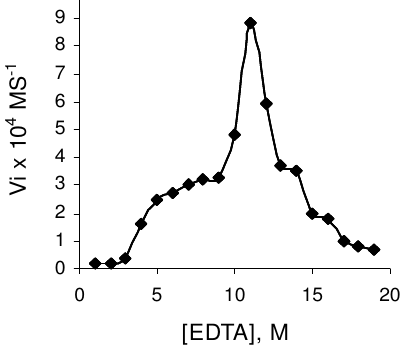
Figure 3. Effect of EDTA on initial rate at [Fe(CN) 64- ] = 3.5 X 10 -2 M, [Hg 2+ ] = 3 x 10 -5 M, pH = 5, Temp =25 0 C and I = 0.1 M (KNO 3